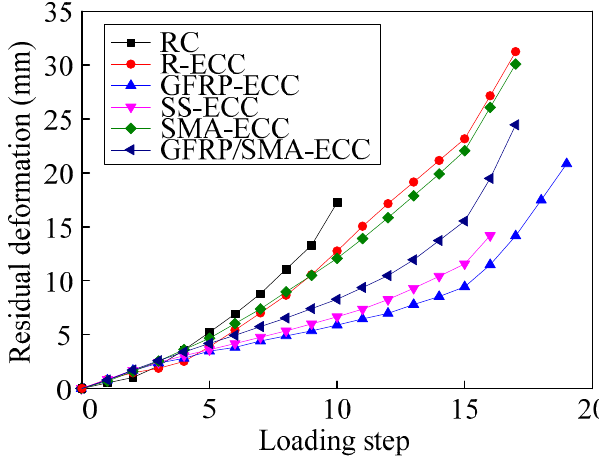
Figure 11. Residual deformation with increasing loading step.